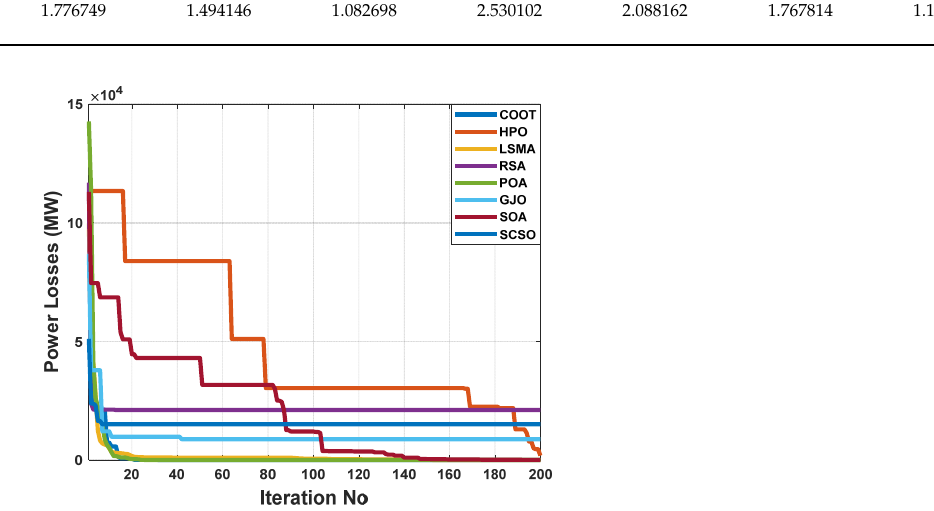
Figure 23. The voltage profile of the POA and other compared algorithms for case 2 in a standard IEEE 57-bus test system. Case 3: Voltage Deviation Minimization The aim function to be improved using the POA algorithm in this part is decreasing voltage deviation. The voltage profile performance can be illustrated by Figure 24. Figure 25 illustrates the pattern of decreasing system voltage divergence. Table 9 indicates that the voltage deviation index is brought down to 0.755485 pu by using the POA algorithm. The POA method significantly outperforms other population-based optimization strate- gies in Table 9, which compares solutions obtained using these methods. Table 9. Optimal control variables for the IEEE-57 bus test system for minimizing voltage deviation. Items